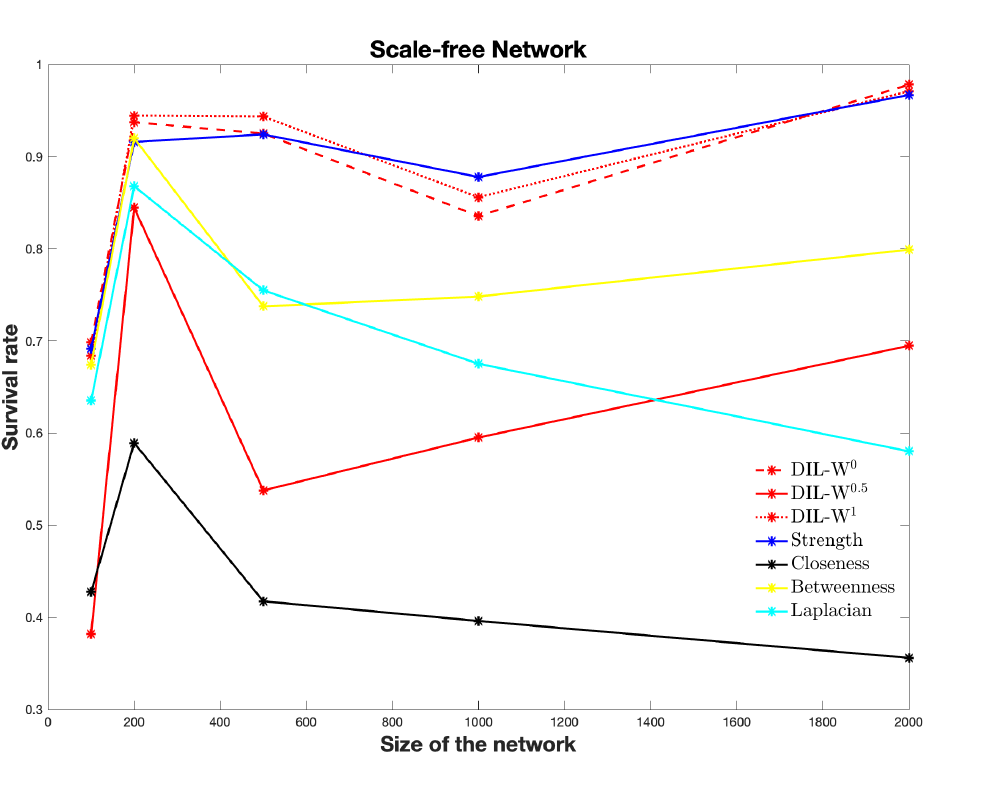
Figure 5. σ as a function of N on a Scale-free network with d = 5.